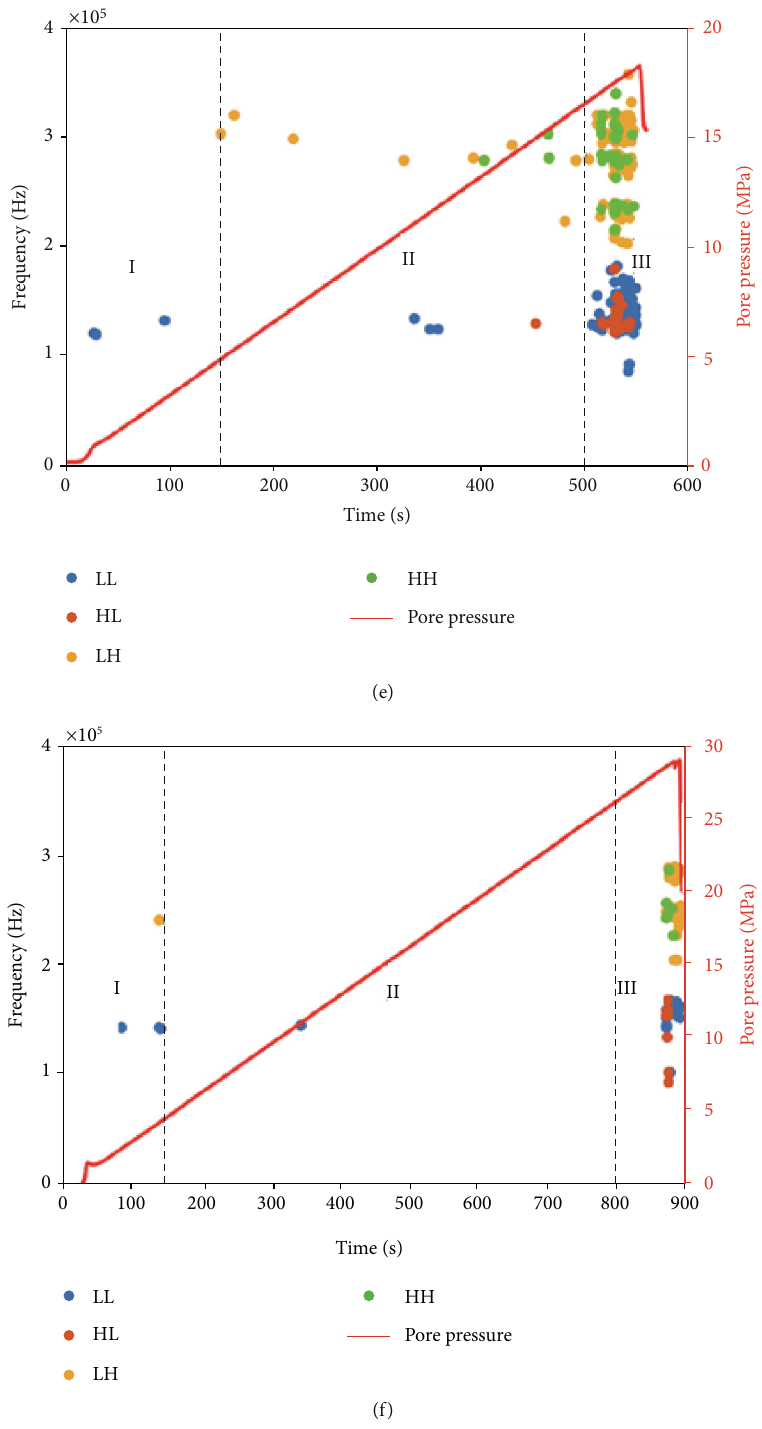
Figure 12: Time-frequency characteristics of the AE signals. (a – f) correspond to the results of H1, T1, H2, T2, H3, and T3,